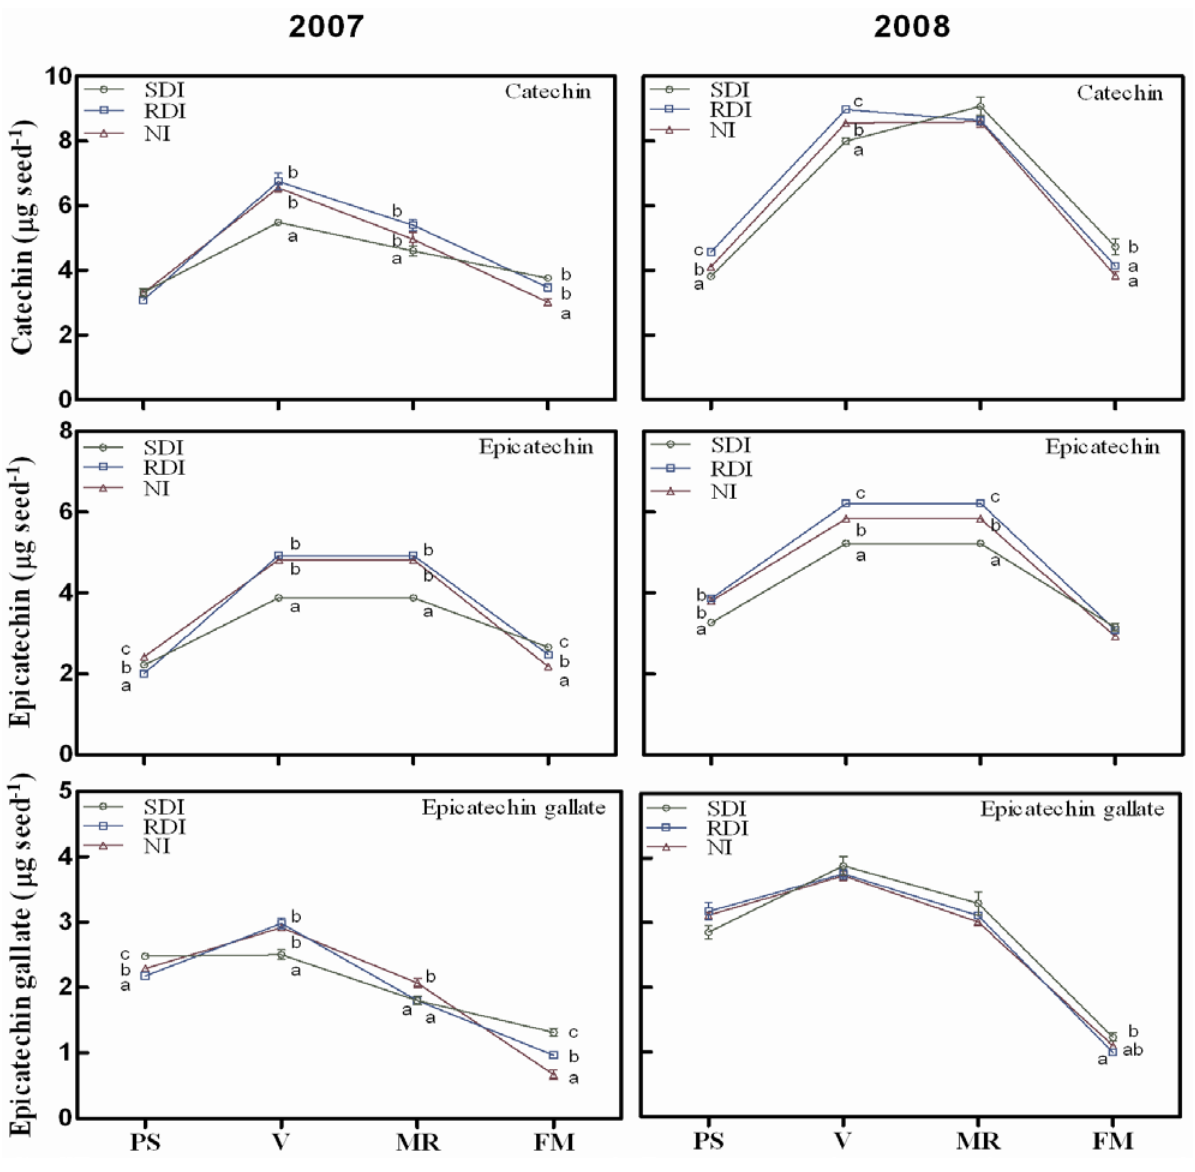
Figure 1. Changes in flavanol monomers during ripening of grape berry seeds in sustained deficit irrigation (SDI), regulated deficit irrigation (RDI) and non-irrigated (NI) treatments during 2007 and 2008 seasons. Values presented are means ± SE ( n ≥ 4). Different letters (a, b, c) indicate significant differences among treatments at the same date using Duncan’s test ( p ≤ 0.05). PS: end of pea size (7 weeks after anthesis); V: veraison (9 weeks after anthesis); MR: mid-ripening (11 weeks after anthesis); and FM: full maturation (13 weeks after